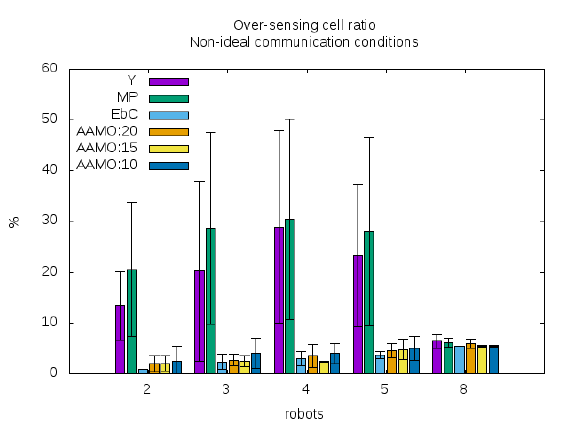
Figure 28. Over-sensing ratio (OSR) under non-ideal communication conditions. The Yamauchi and MinPos approach results (coloured in purple and green, respectively) obtained under ideal communication conditions are placed together to make the comparison